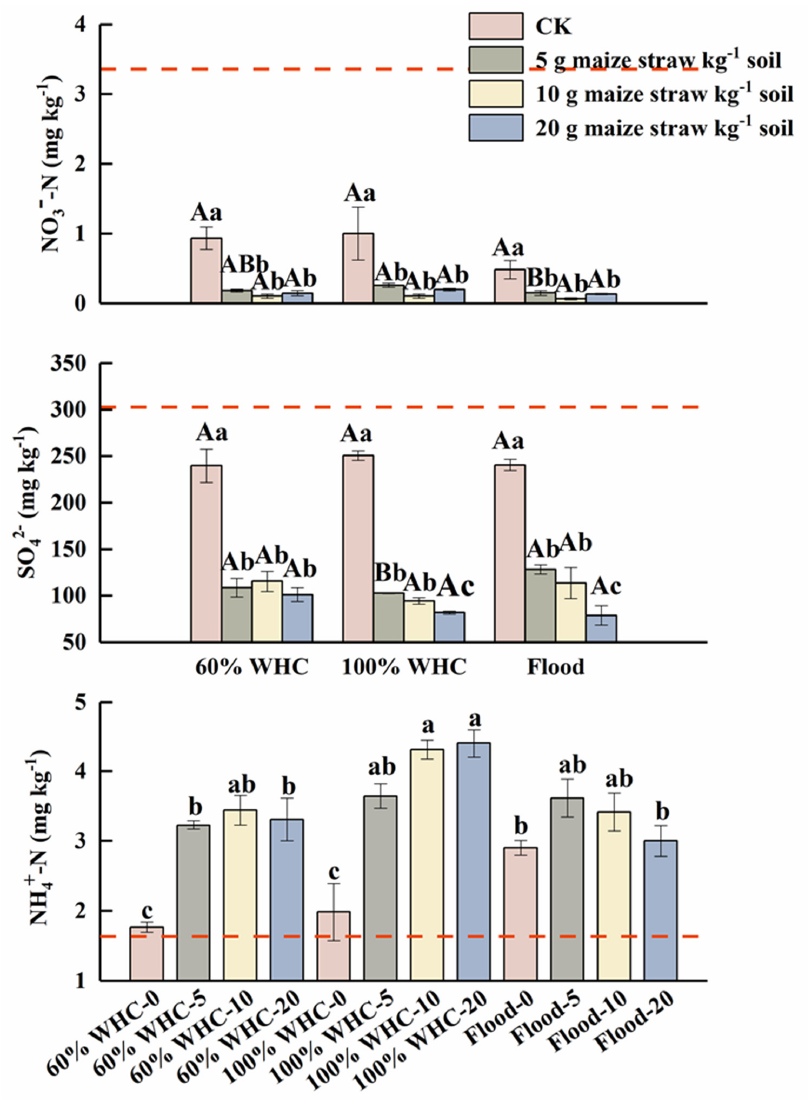
Figure 2. The contents of NO 3 − , SO 42 − and NH 4+ after RSD treatment. Error bars indicate standard deviations. Different uppercase letters implicate the significant difference among the same maize straw amended rate under the different soil water contents of NO 3- and SO 42 − , and lowercase letters within the same water content show a significant difference among the various maize straw amended rates (SNK tests, p < 0.05). Different lowercase letters show a significant difference among the various treatments of NH 4 + (SNK tests, p < 0.05). The dashed lines represent the initial value of the original